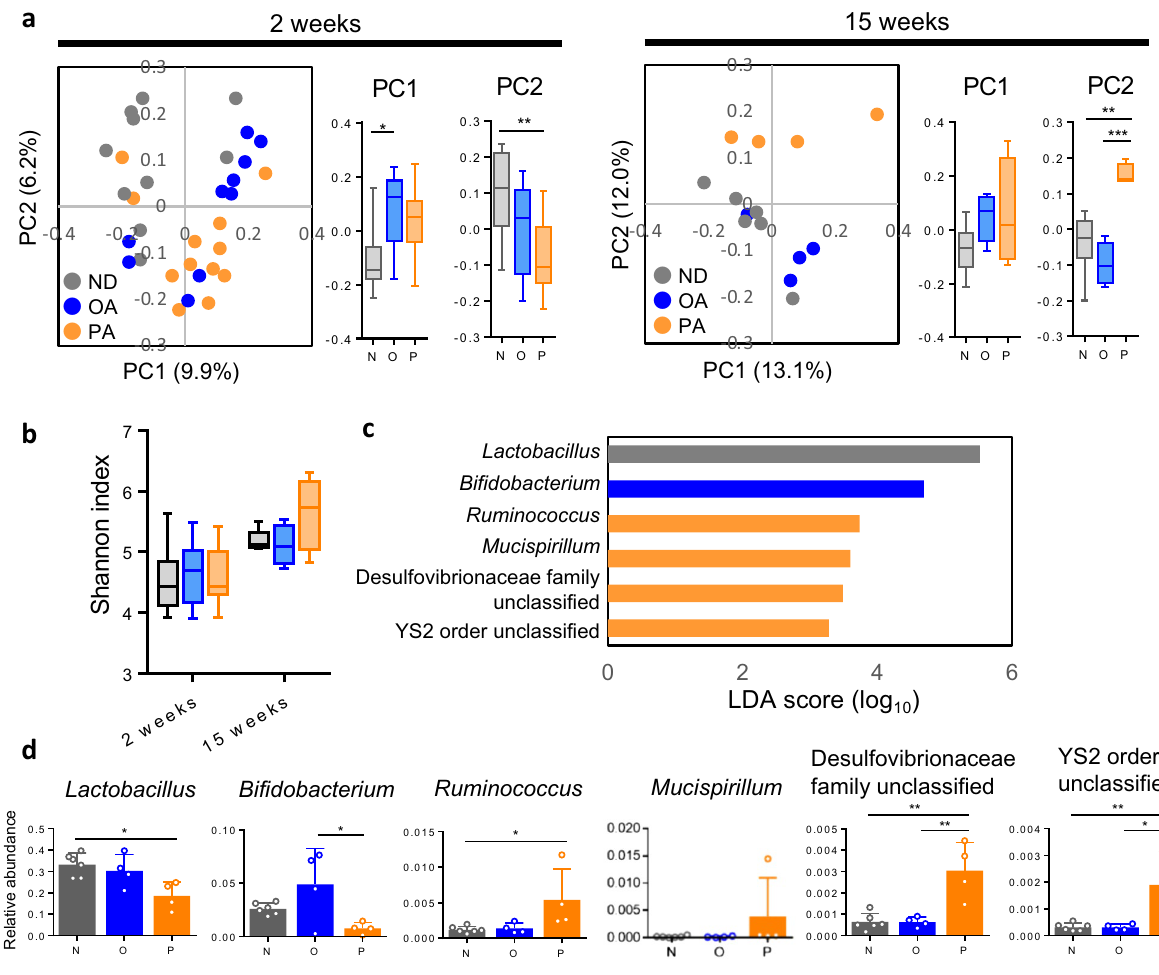
Figure 8. PA milk-fed mice have a unique microbiota different from ND and OA milk-fed mice. ( a ) PCoA of beta-diversity using the unweighted unifrac distance and ( b ) alpha diversity (Shannon index) of ND ( n = 10), OA ( n = 10) and PA ( n = 12) milk-fed mice at 2 and 12 weeks of age. ( c ) Results of LEfSe analysis showing the genus that were significantly different in abundance among ND ( n = 6), OA ( n = 4) and PA ( n = 4) milk-fed mice at 12 weeks of age. Gray, blue and orange indicate the bacteria with increased abundance in ND, OA and PA milk-fed mice, respectively. ( d ) Validation with one-way ANOVA analysis using relative abundance of the genus selected by LEfSe analysis. Data are represented as mean ± SD. * P < 0.05, ** P < 0.01, *** P < 0.001, One-way ANOVA with post-hoc Tukey’s multiple comparison test. Data are analyzed with Prism8 (version 8.4.3, https:// www. graph pad. com/ scien tific- softw are/ prism) and QIIME2 (version 2017.6, http:// qiime.